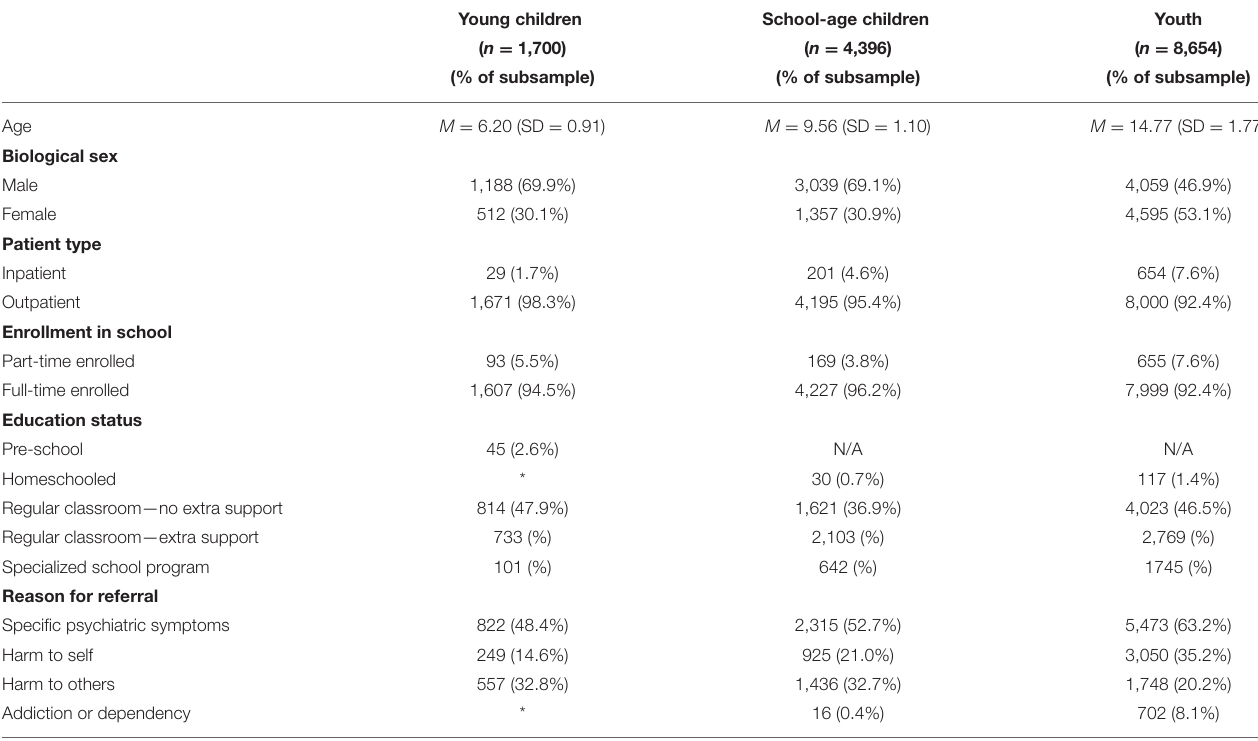
TABLE 1 | Sample demographic information by age